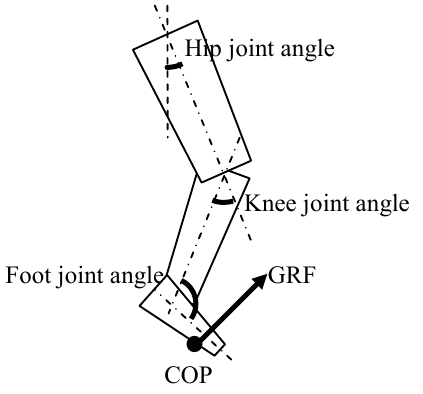
Fig. 2 Analytical model of calculation part for joint torque